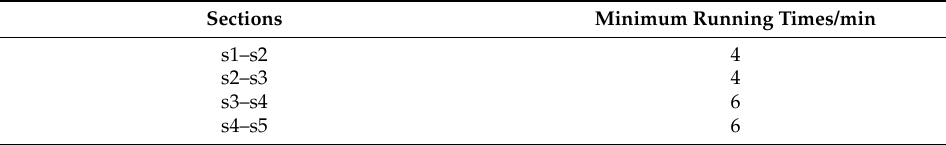
Table A1. The minimum running times in each section.